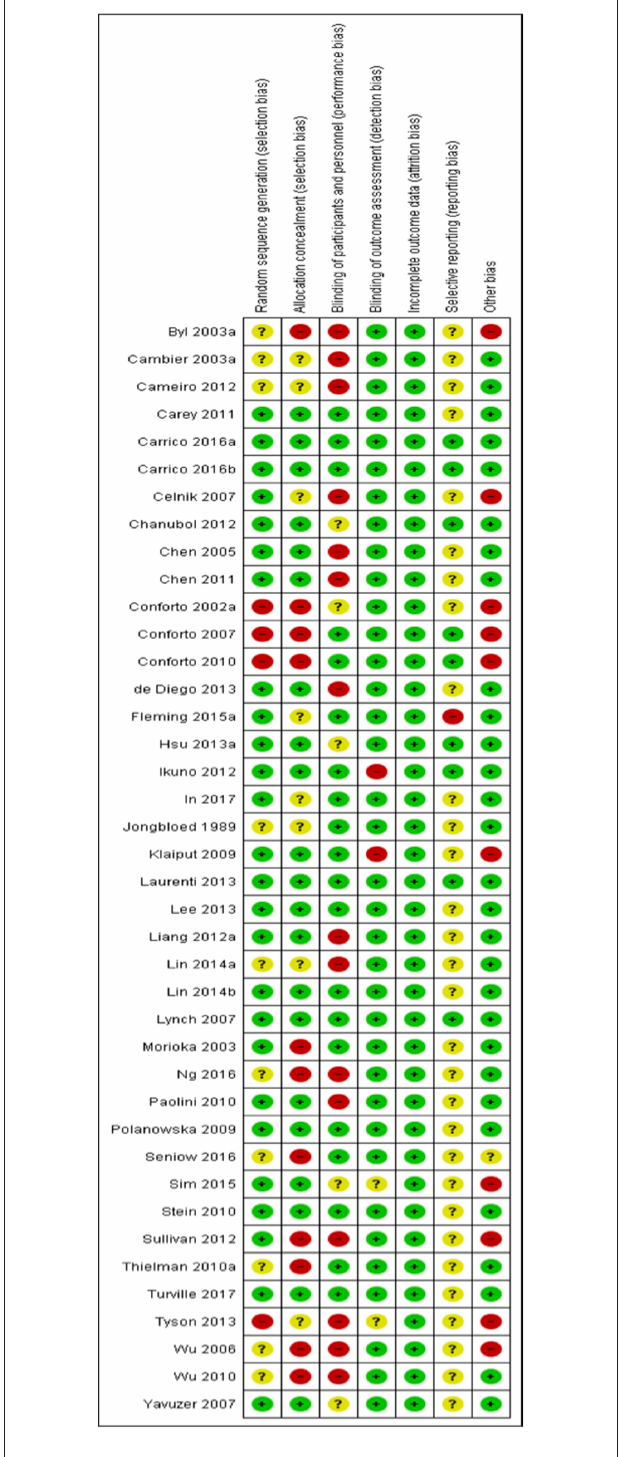
FIGURE 3 | Risk of bias summary for each included study.